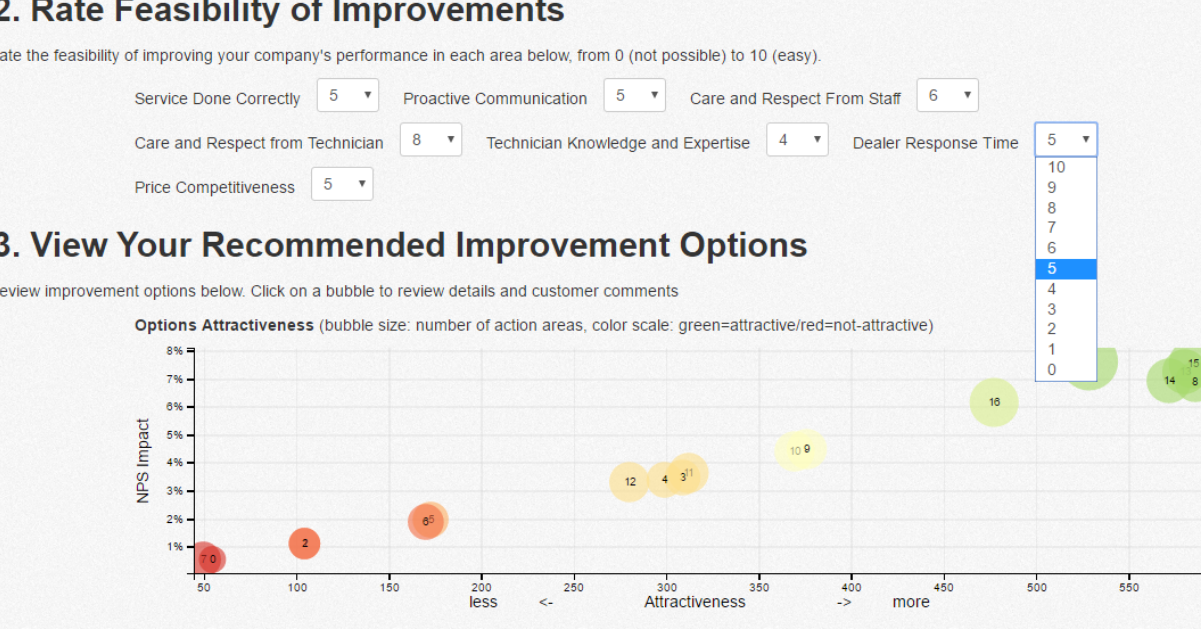
Figure 3. Web-based interactive visualization for displaying the system’s recommendations, which are placed on a two-dimensional chart and color-coded according to their attractiveness, as determined by their feasibility and NPS